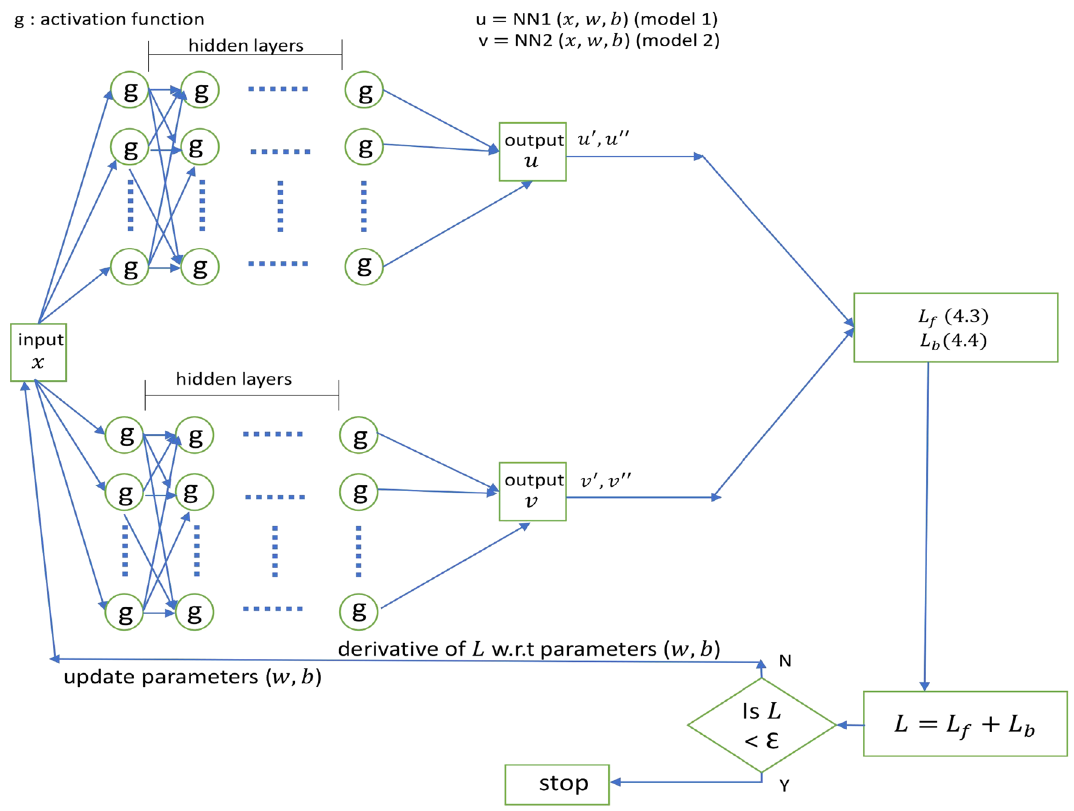
Figure 4. Schematic representation of PINN for coupled equation.